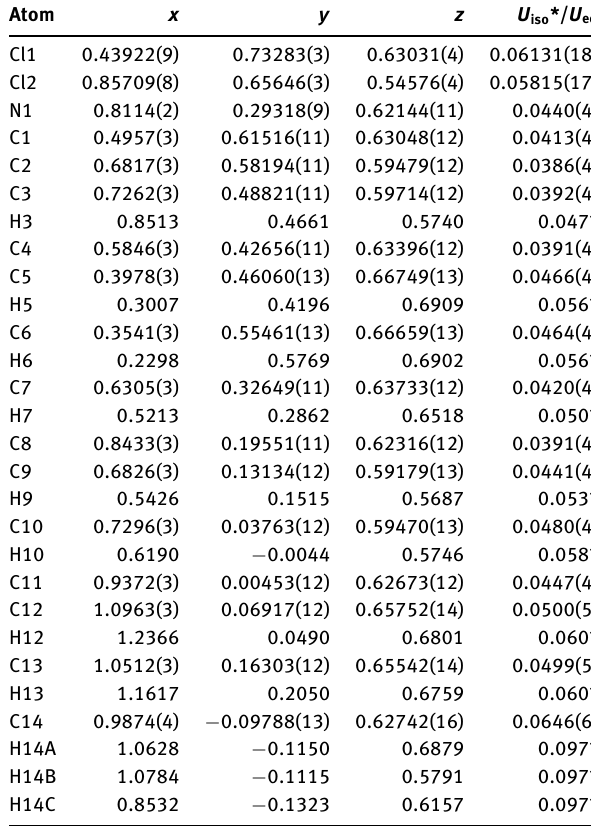
Table 2: Fractional atomic coordinates and isotropic or equivalent isotropic displacement parameters (Å 2